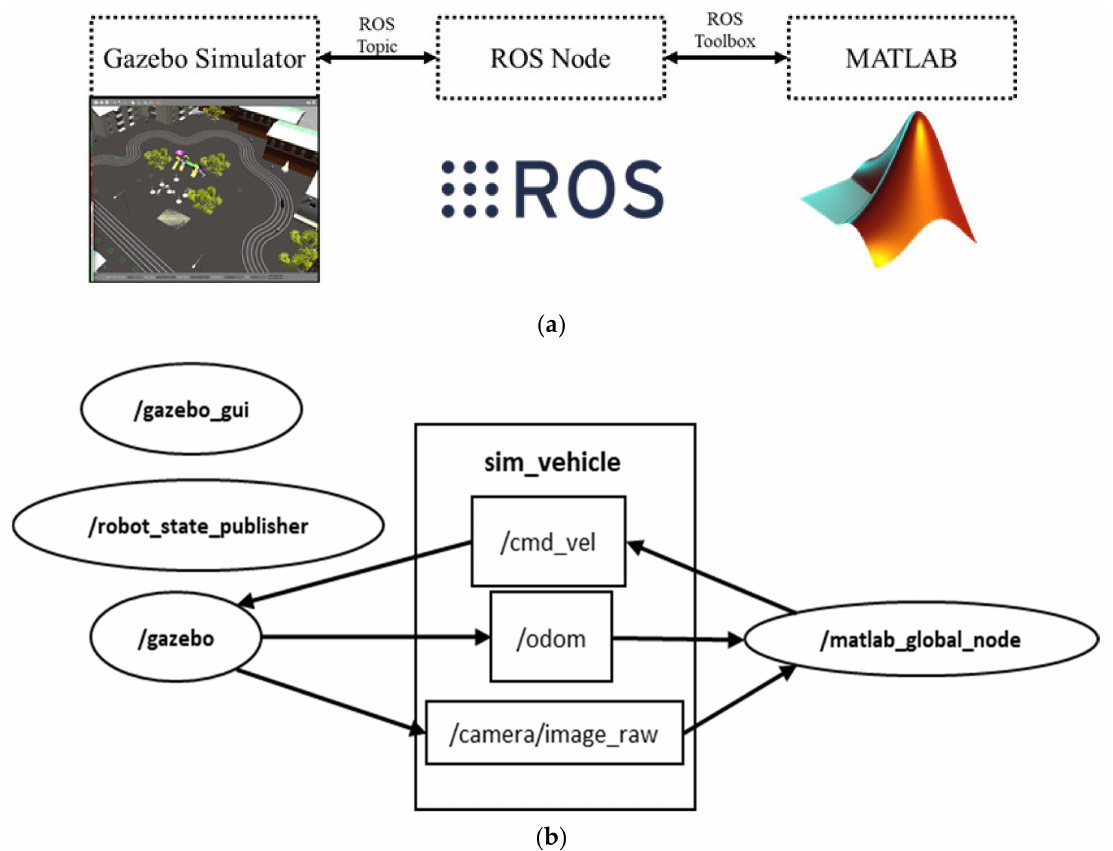
Figure 11. Gazebo-MATLAB Software Communication; ( a ) Brief Visualization of Software Architecture, ( b ) RQT